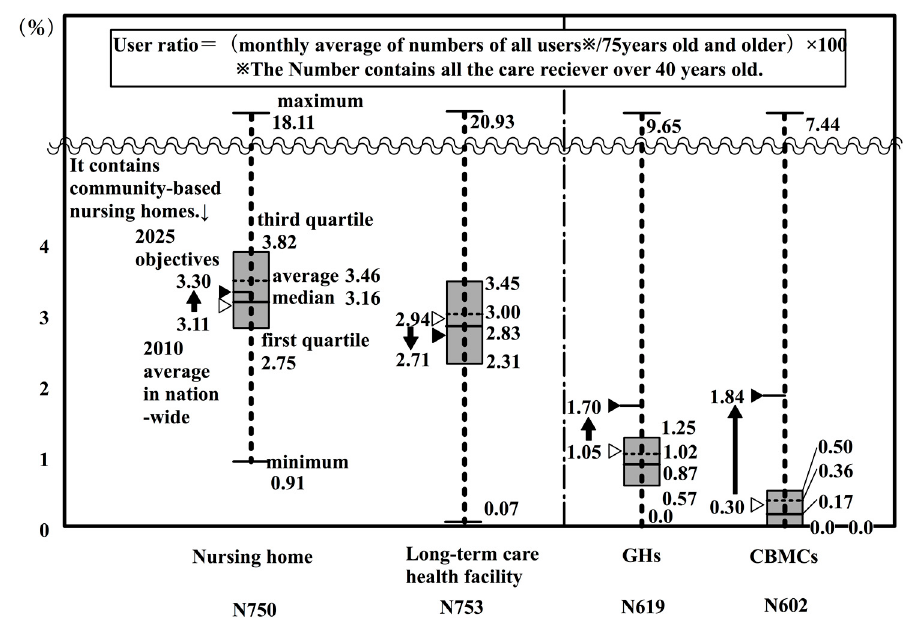
Figure 3. User rate for persons 75 years or older in nationwide insurers’ nursing homes, long-term health facilities, GHs, and community-based multi-care facilities (CBMCs).